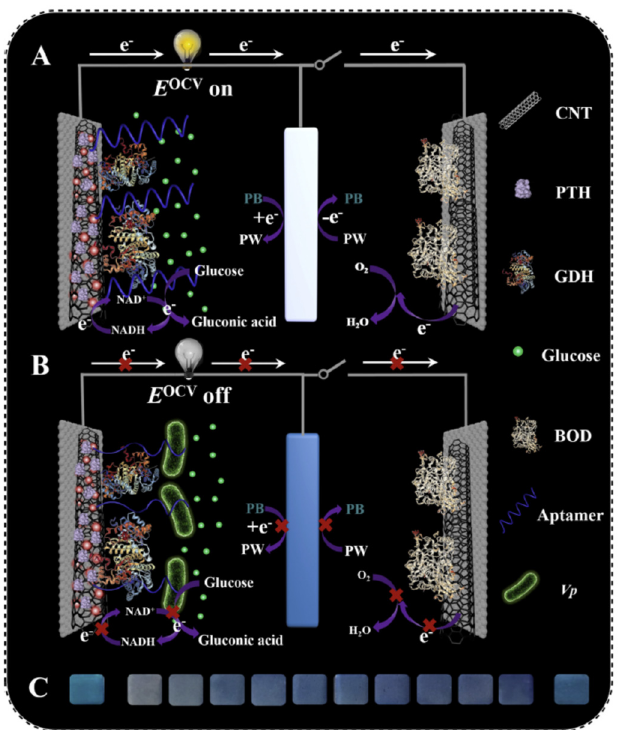
Figure 6. Schematic illustration of EBFCs-based self-powered biosensor with the visual self-checking function for Vp determination. ( A ) GDH would oxidize glucose to generate electrons, which could reduce blue PB to white PW; ( B ) when connected with the biocathode electrode, the PW electrode would be oxidized to the original PB state and ( C ) the color conversion between PB and PW realized the self-checking function via visual detection [76]. Copyright 2020 Elsevier.